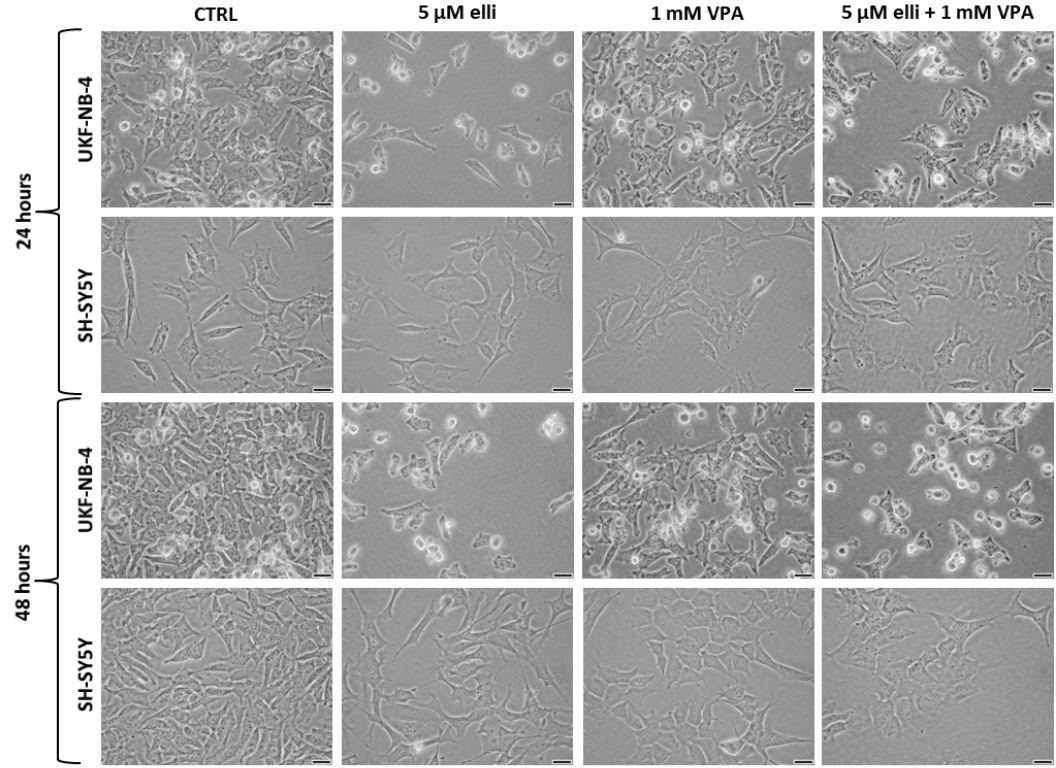
Figure 3. The effect of 24- and 48-h treatment of UKF-NB-4 and SH-SY5Y cells with 5 µM ellipticine, 1 mM valproic acid (VPA) and their combination on the morphology of these neuroblastoma cells (×200). As shown in this figure, VPA changes the morphology of SH-SY5Y cells. Bars at the bottom-right corners = 50 µm.